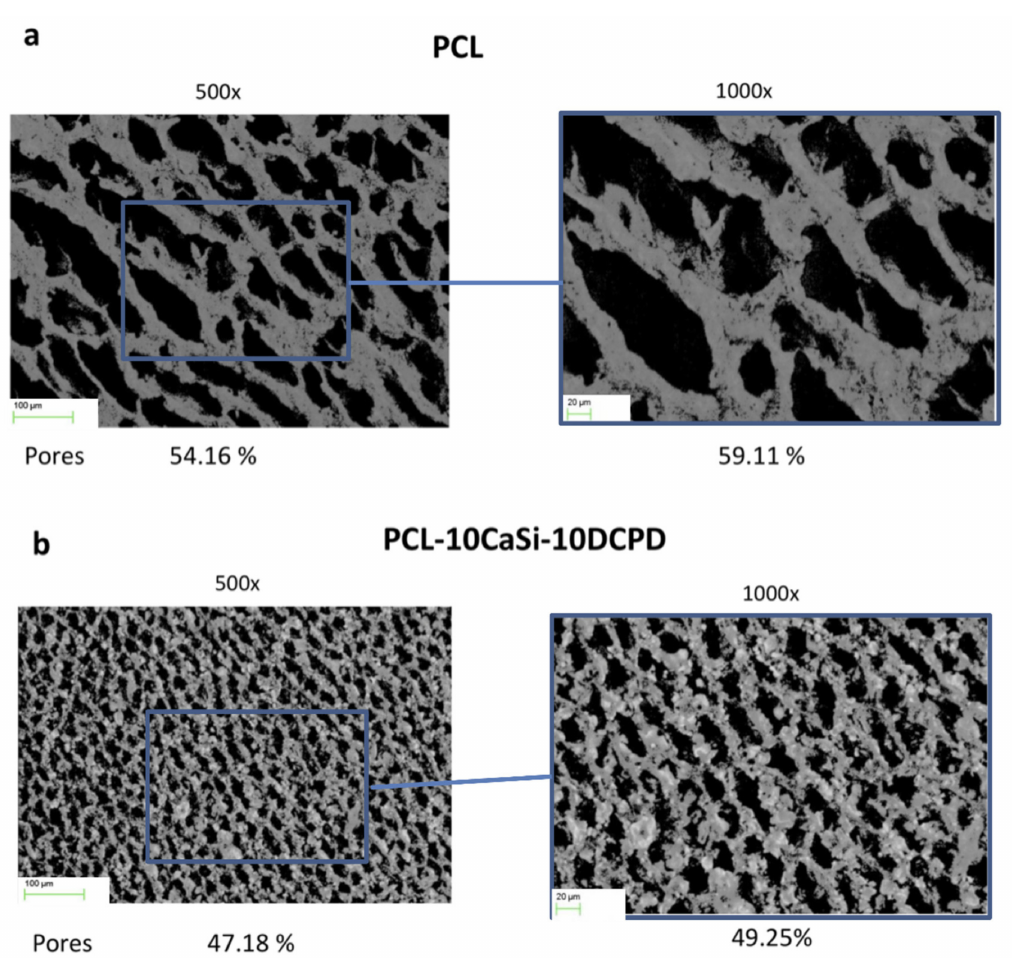
Figure 2. Surface porosity evaluation of PCL ( a ) and PCL-10CaSi-10DCPD ( b ) sca ff olds on one random area at 500 × and 1000 × magnifications. PCL sca ff olds reveal a more regular surface with larger porosities when compared to PLA sca ff olds. CaSi and DCPD mineral fillers are widely distributed on the sca ff old surface, partially occluding the